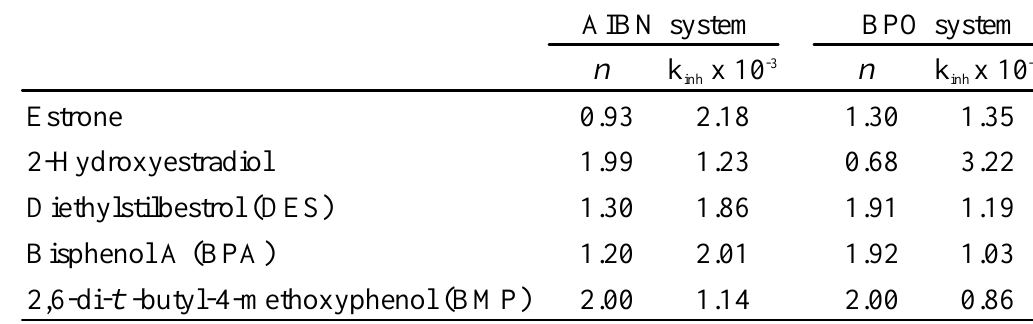
The measurement for antioxidant activities is described in the text. Values are the mean of three independent experiments. Standard error <10%. The determination of n and k is described in the text. The k is approximately 3.7 inh t x 10 7 M -1 s -1